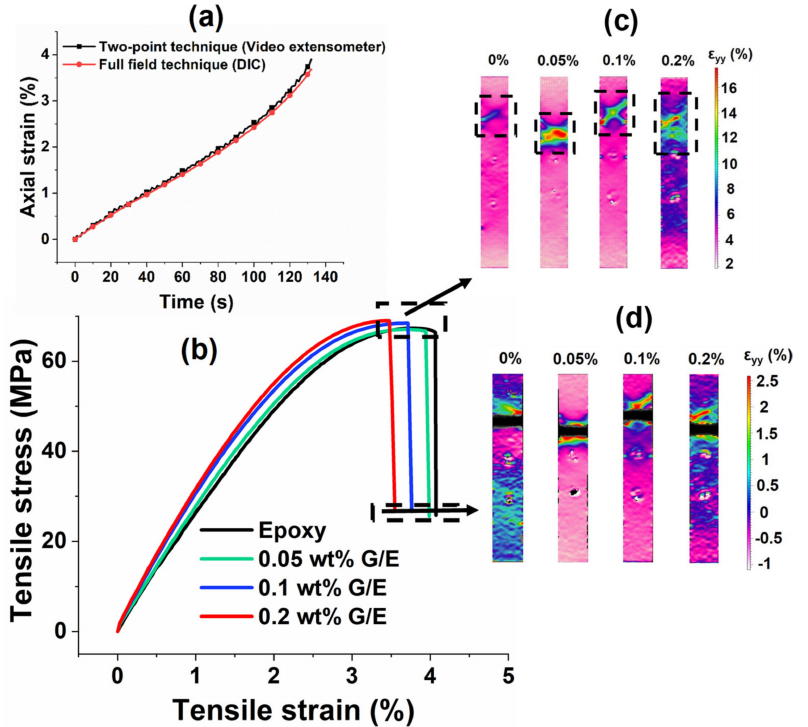
Figure 5. ( a ) Comparison of two-point and full-field axial strain measurement techniques, ( b ) tensile stress vs. strain, ( c ) axial strain ( ε yy ) contour plots of all samples at maximum stress, and ( d ) fracture surfaces shown in black color at the end of the